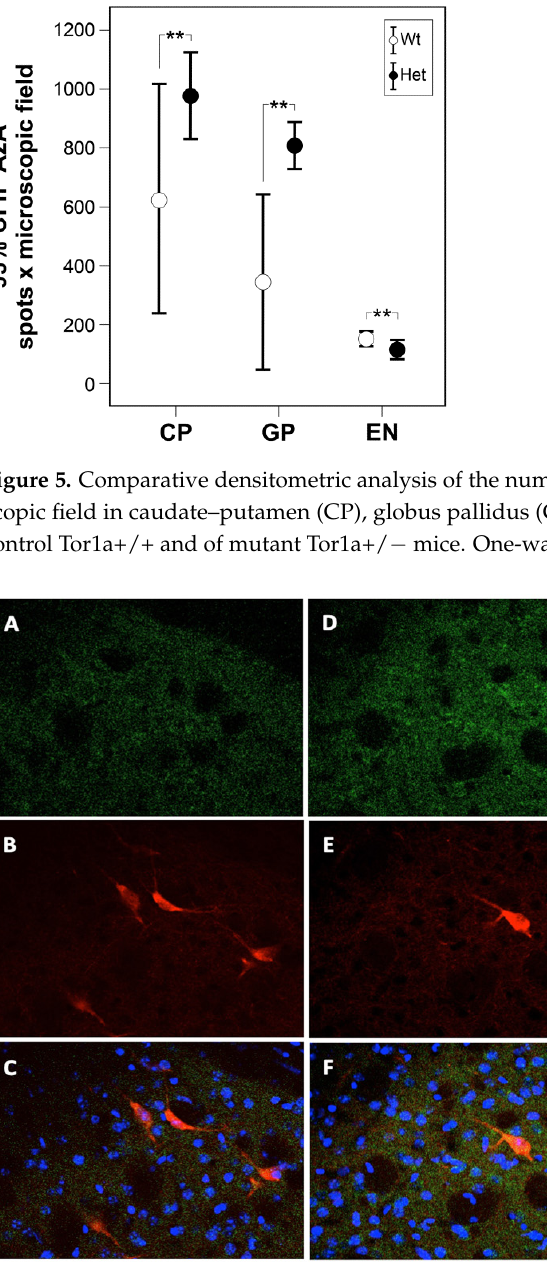
Figure 6. Localization of A2A receptors in cholinergic striatal interneurons. Representative confocal laser scanning mi- croscopy images double-labeled with antibody for anti A2A receptors and with antibody anti-ChAT for cholinergic inter- neurons. A2A receptors are visualized in green-cy2 fluorescence ( A,D ); ChAT positive neurons are visualized in red-cy3 fluorescence ( B,E ); merged images in C, F with A2A positive grains visualized in yellow on ChAT-positive interneurons, and in green in the neuropil. Cell nuclei are visualized by DAPI fluorescence in blue. A,B,C ) Tor1a+/+ mice; D,E,F ) Tor1a +/– mice. Scale bar in F = 50 μ